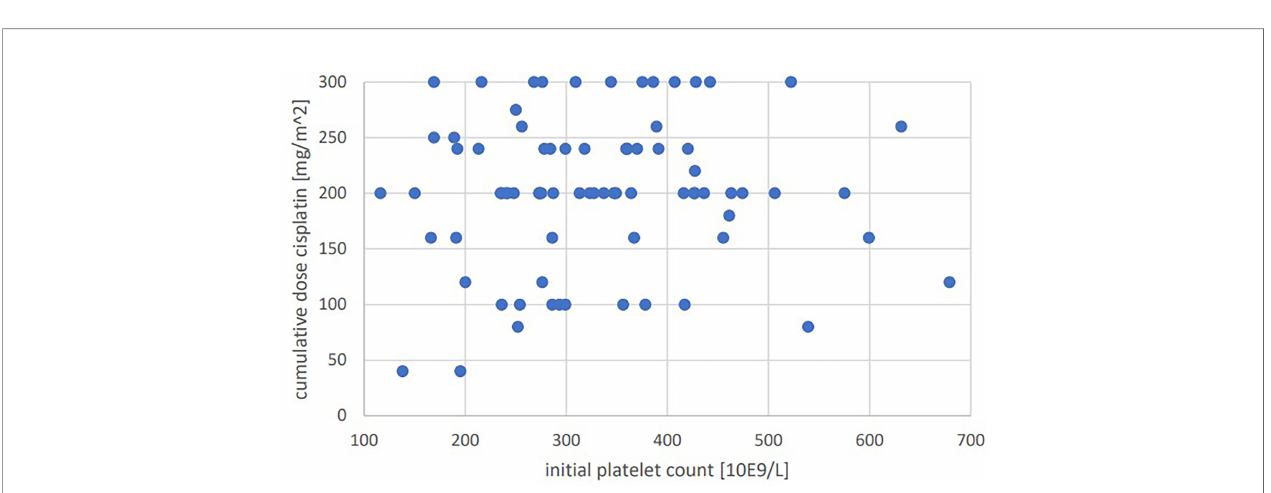
FIGURE 5 | Bivariate correlation analysis of initial leucocyte count [10E9/L] with fi nal cumulative total dose of cisplatin achieved [mg/m^2]: p=0.177, no signi fi cant correlation; individual values as points.